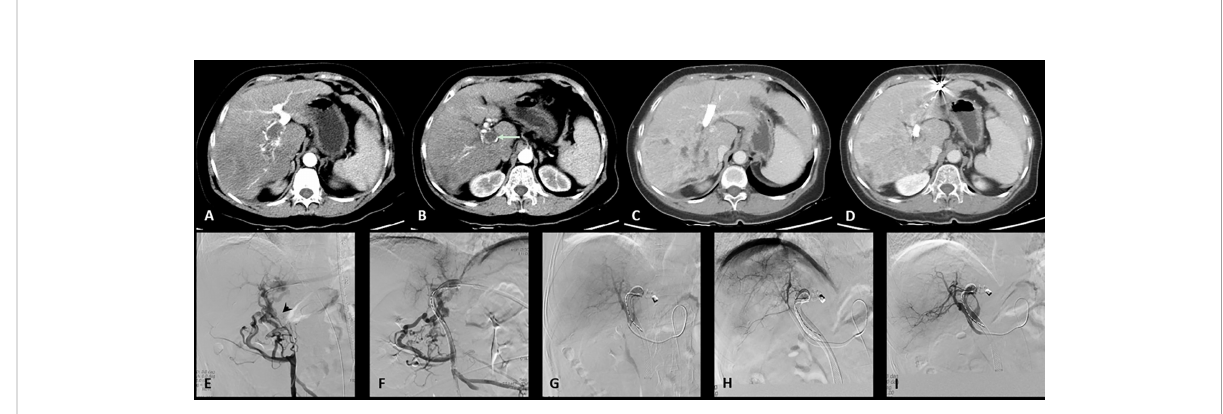
FIGURE 2 One case of the D-TACE group. The patient was a 69 years old female. (A) : Preoperative CT images showed a huge tumor in the right lobe of the liver. (B) : Tumor thrombus (arrow) was seen in the right branch and main portal vein. (C) : After 3 months follow up, the tumor was signi fi cantly reduced. (D) : The patency of portal vein stent was revealed after 3 months follow up. (E) : Filling defect was showed in the main portal vein (arrow head) during venography. (F) : Portal vein stent (diameter: 10 mm, length: 94 mm) was implanted and 20 125I radioactive seeds were used. (G) : Hepatic artery angiography showed large tumor staining of the right lobe of the liver. (H) : Superselective embolization of the tumor artery branches with 40 milligrams of epirubicin mixed with one bottle of DC beads. (I) : Angiography after embolization, tumor blood supply was signi fi cantly reduced.